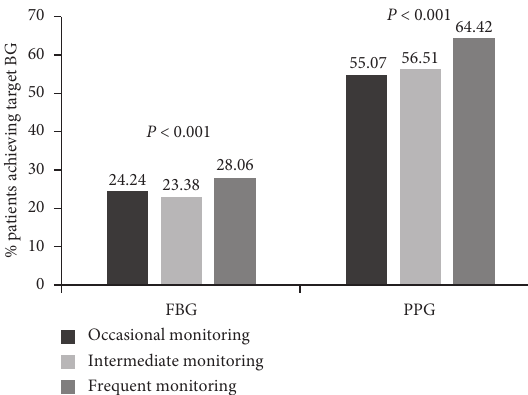
Figure 3: Percentage of patients achieving target FBG and PPG at baseline and week 12. BG, blood glucose; FBG, fasting blood glucose; PPG, postprandial